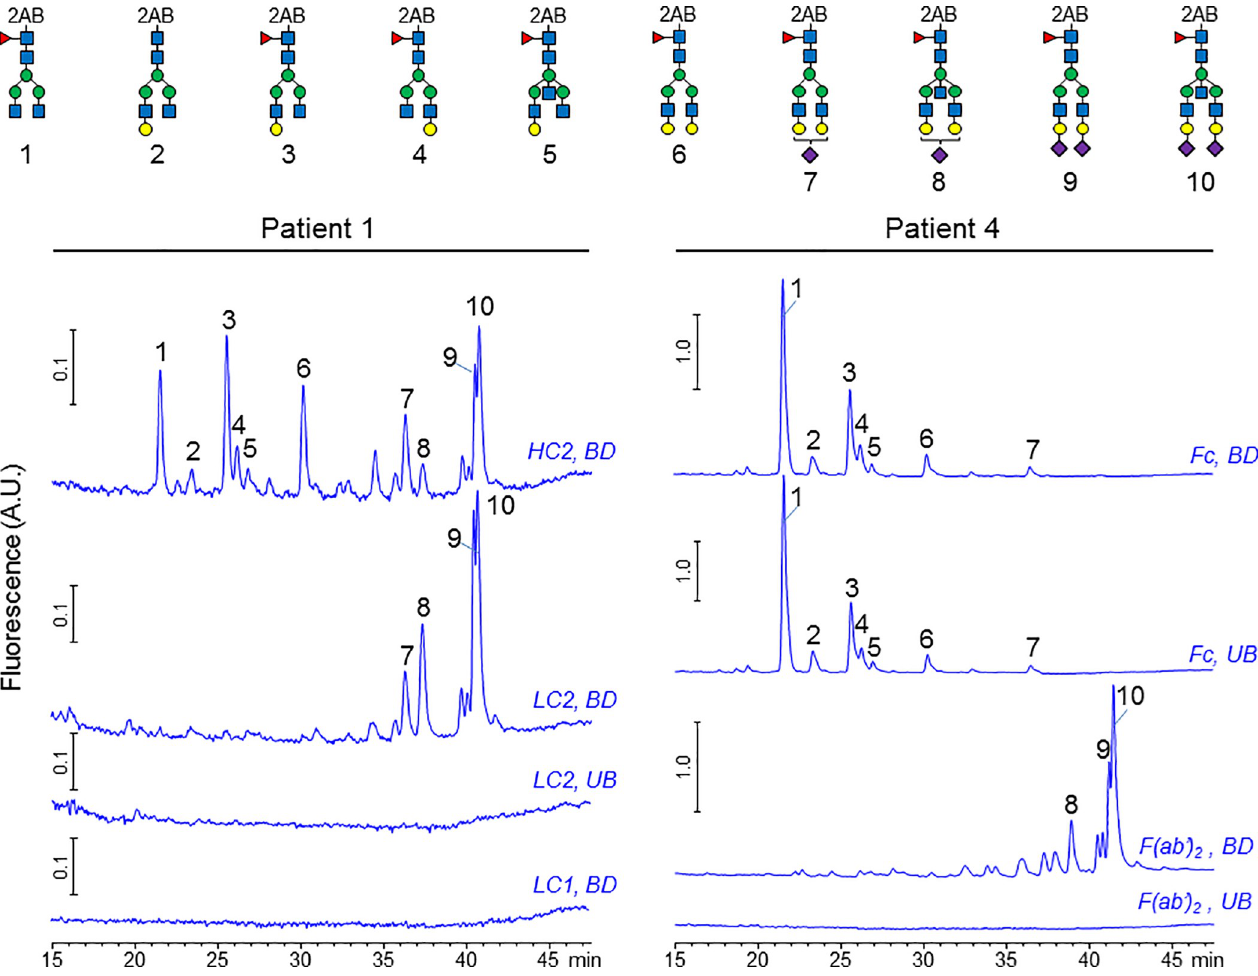
Fig 8. Carbohydrate profile of SNA-enriched IgGs relative to unbound fraction. Glycans were released by in-gel PNGase F treatment and labeled with 2-aminobenzamide. The label glycans were separated by HPLC with fluorescence detection. Top: Structures of the 2-AB labeled glycans detected with numbers corresponding to the respective peaks on each chromatogram. Bottom: HPLC chromatograms of 2AB-labeled N -linked glycans. LC: light chain, HC: heavy chain, UB: unbound fraction (Sialic-depleted IgG), BD: bound fraction (Sialic-enriched IgG).